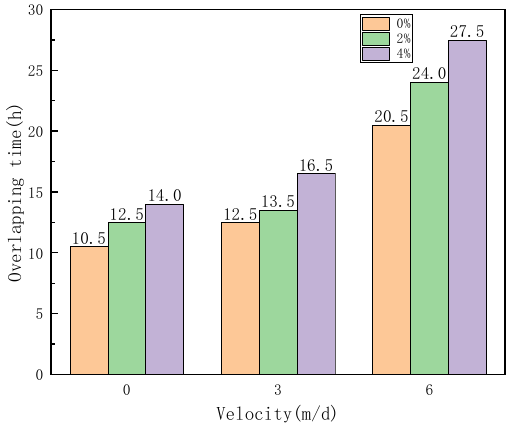
Figure 11. The overlapping time of double-pipe freezing.